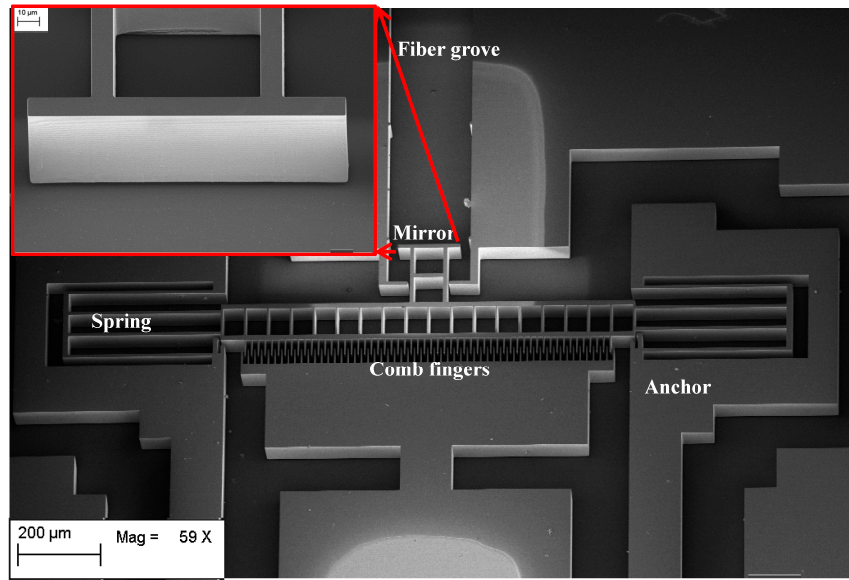
Figure 8. An scanning electron microscope (SEM) image of design A MEMS actuator with the insert showing a close-up of the micromirror surface prior to gold metallization. (Scale bar 10 μ m ( inset )).